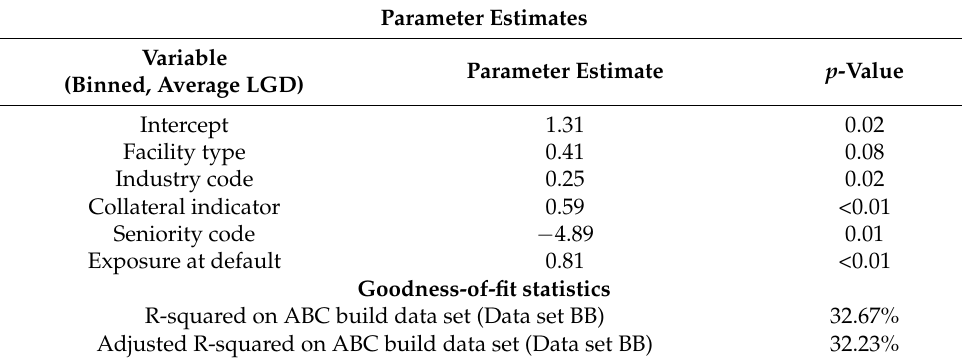
Table 3. Regression results of the ABC build data set (Data set BB).